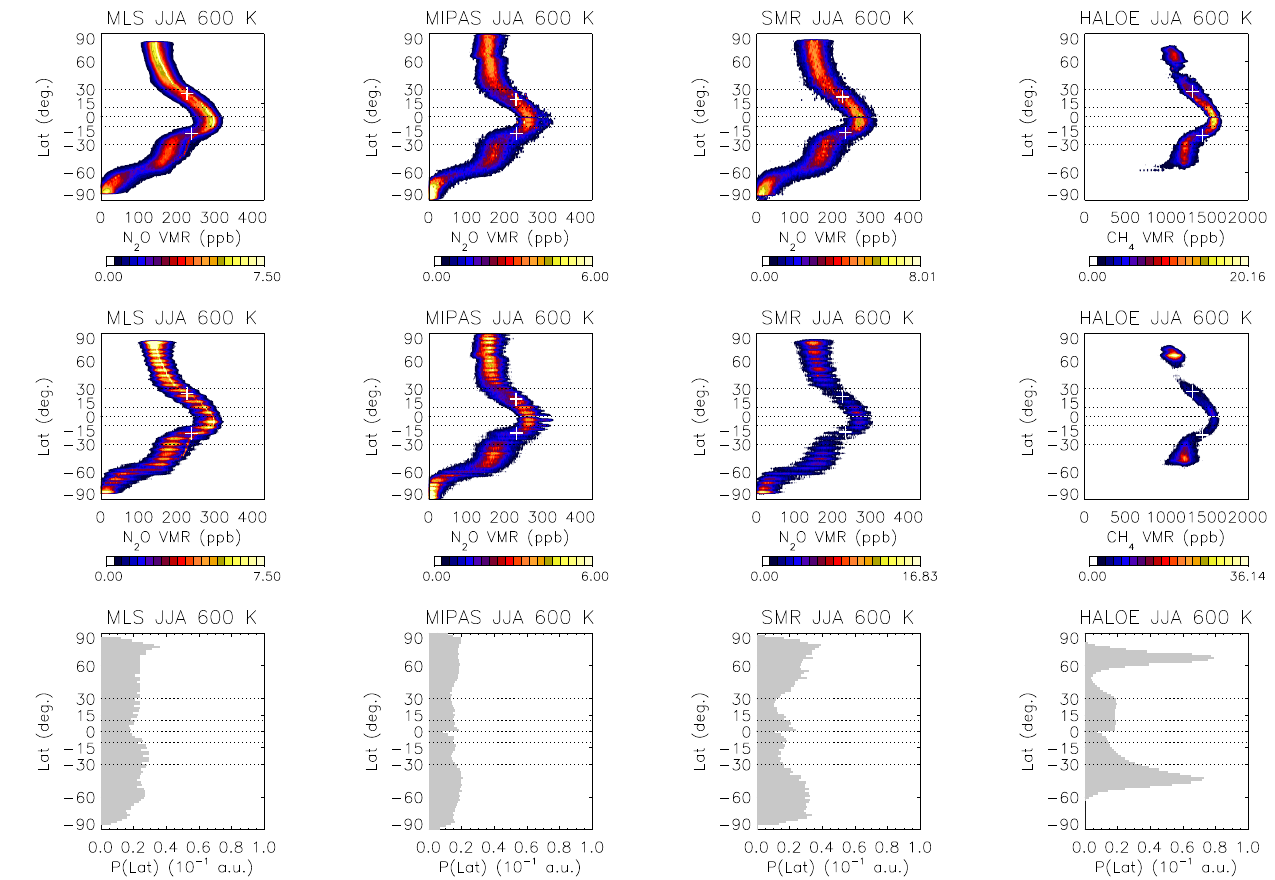
Fig. 3. Annual mean June-July-August (JJA) (upper row) conditional PDFs, P(χ | φ) , and (middle row) joint PDFs, P(χ ∩ φ) , of tracer VMR concentrations (N 2 O for MLS, MIPAS, SMR and CH 4 for HALOE, from left to right) and latitudes φ at 600K ( ∼ 30hPa). The lower row shows the normalized frequency distribution of the latitudes, P(φ) , on average during JJA.